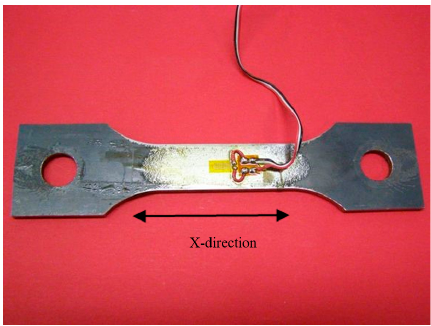
Figure 3. The dog-bone shape geometry of the Fe360 sample used for the mechanical test. In the picture the electrical wires are connected to the strain gage sensor glued on the yellow area as shown in the photo.